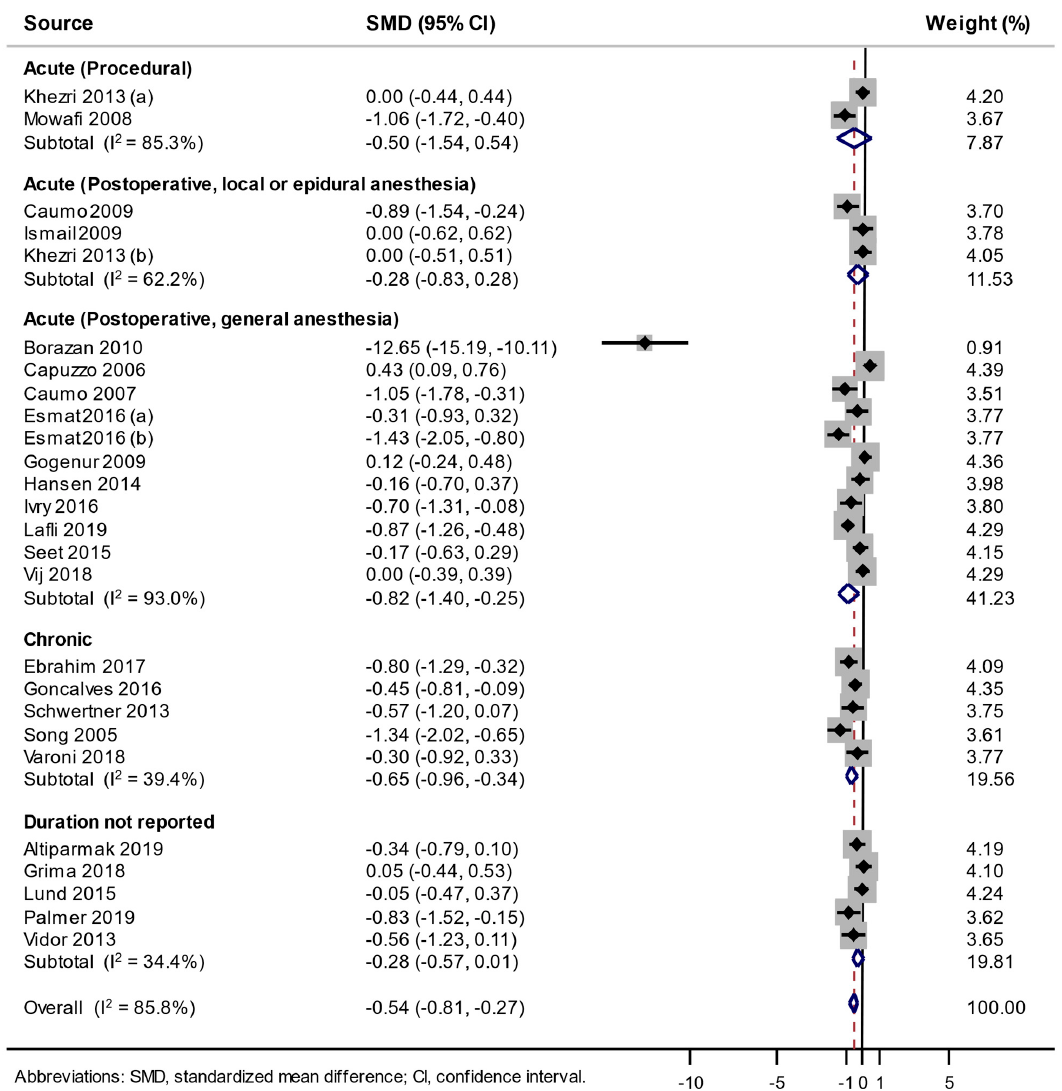
Figure 2. Use of melatonin and change of pain score in a random-effects meta-analysis of randomized, double-blind, placebo-controlled trials.